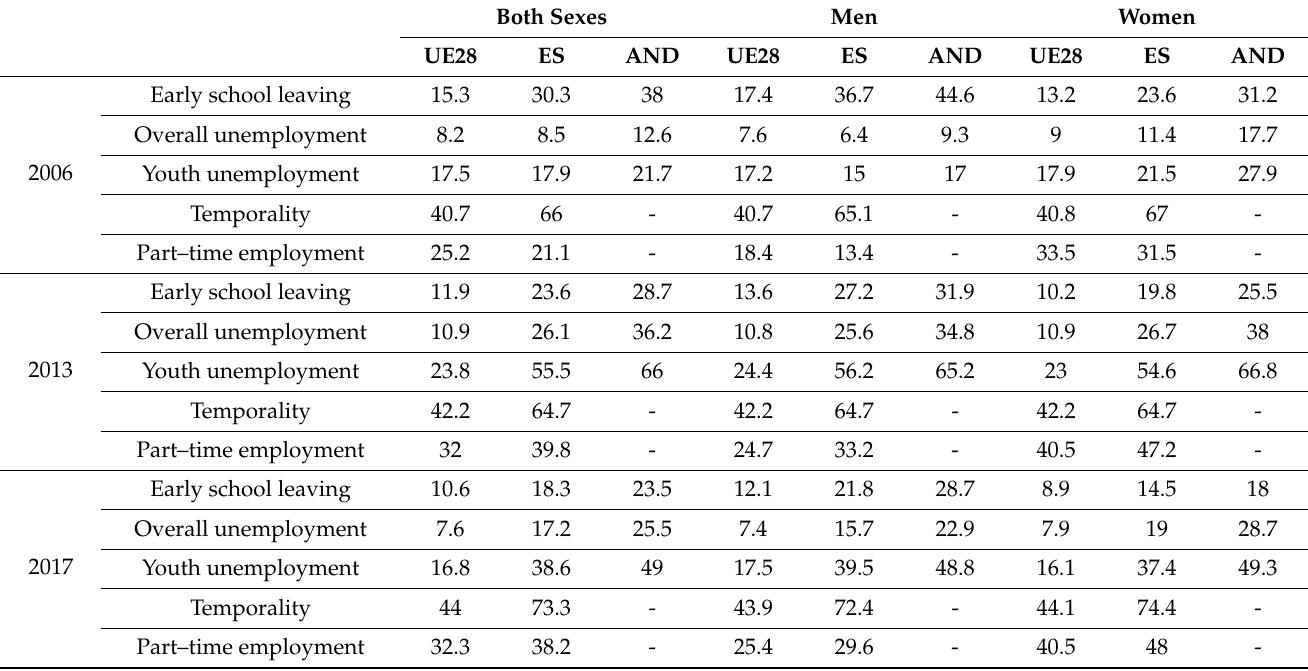
Table 1. Indicators concerning living conditions in the European Union (EU28), Spain (ES) and Andalusia (AND), in percentages. Both Sexes Men UE28 ES